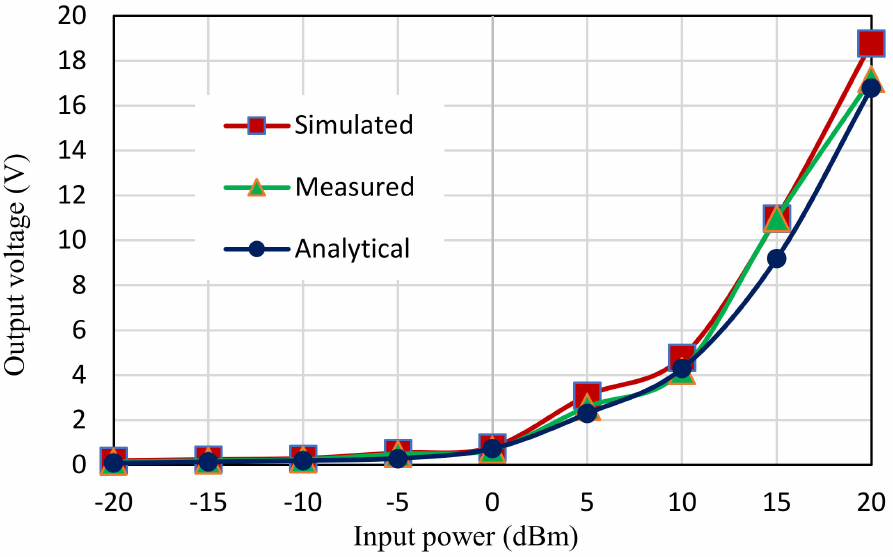
Figure 19. Output voltage versus input power for Cockcroft-Walton voltage multiplier rectifier.